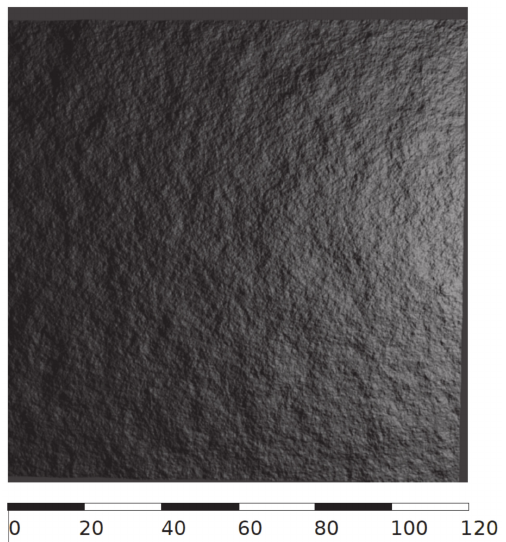
Figure 17. A 3D image of the random field realisation of the original surface P20.